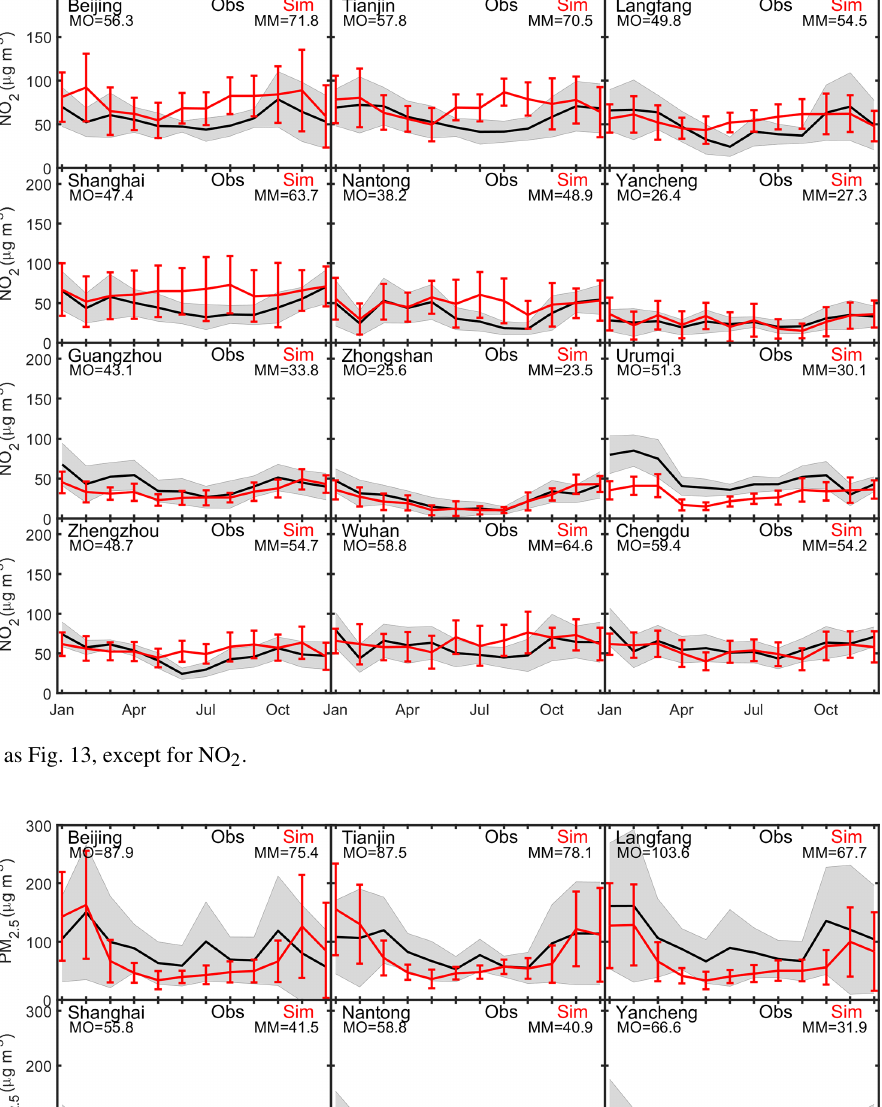
Figure 14. The same as Fig. 13, except for NO 2 .